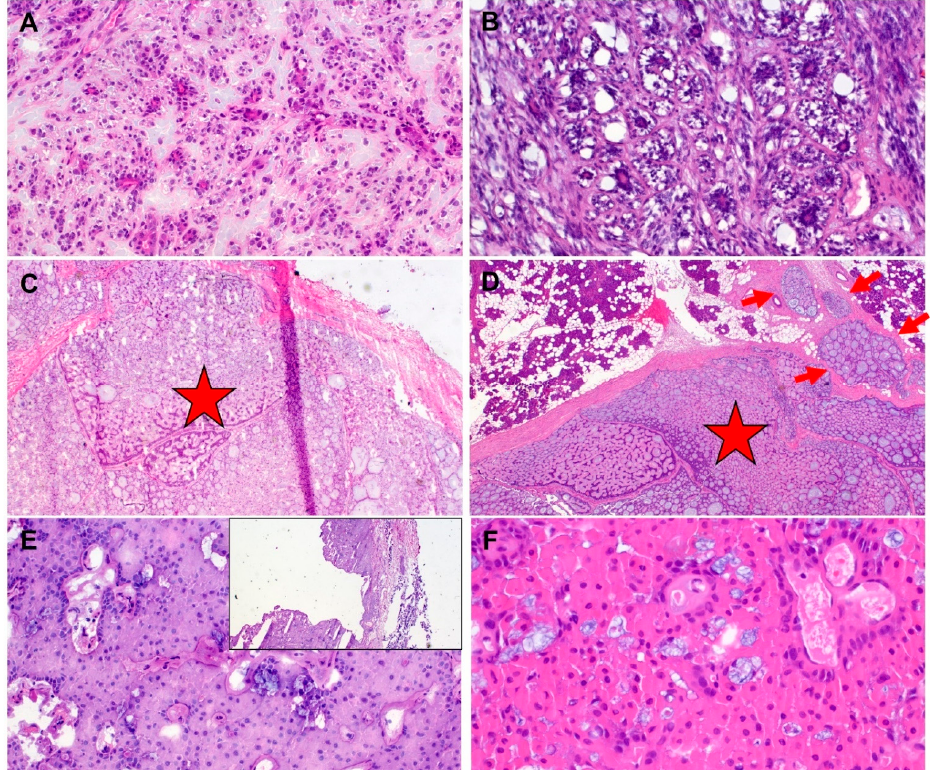
Figure 2. ( A ) (frozen section) and ( B ) (permanent section) of epithelial-myoepithelial carcinoma. This rare entity is essentially not reliably distinguishable from pleomorphic adenoma with diffuse ductal component interrupted by myoepithelial cells (interpretative error). This applies frequently to both general surgical pathologists and head and neck pathologists. ( C ) (frozen section) and ( D ) (permanent section) of adenoid cystic carcinoma with predominantly encapsulated pattern (stars). This interpretative error is frequently seen in cases seen by general surgical pathologists but not by head and neck pathologists. A focal invasive component (red arrows) was also present in the frozen section (interpretative error). ( E ) (frozen section) and ( F ) (permanent section) of cystic and oncocytic mucoepidermoid carcinoma misinterpreted as cystadenolymphoma (“Warthin’s tumor”) by the general surgical pathologist, despite absence of lymphoid tissue and bilayered oncocytes and presence of multifocal mucus cells (interpretative error). Small image: overview showing solid and cystic lesion. The drawback of FS as a primary diagnostic modality for salivary gland lesions is mainly a reflection of the complexity of the morphology of salivary gland tumours and of the significant overlap between different benign and malignant entities. In contrast to many other organs, malignancy in salivary gland carcinomas is not always defined by the